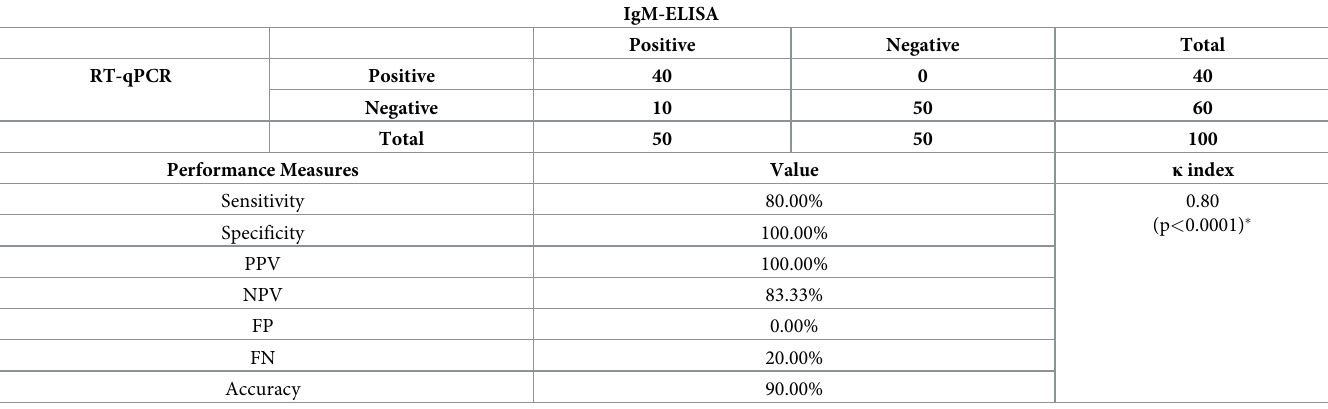
Table 6. Contingency table showing the results obtained by RT-qPCR compared with those obtained by IgM-ELISA as reference assay.